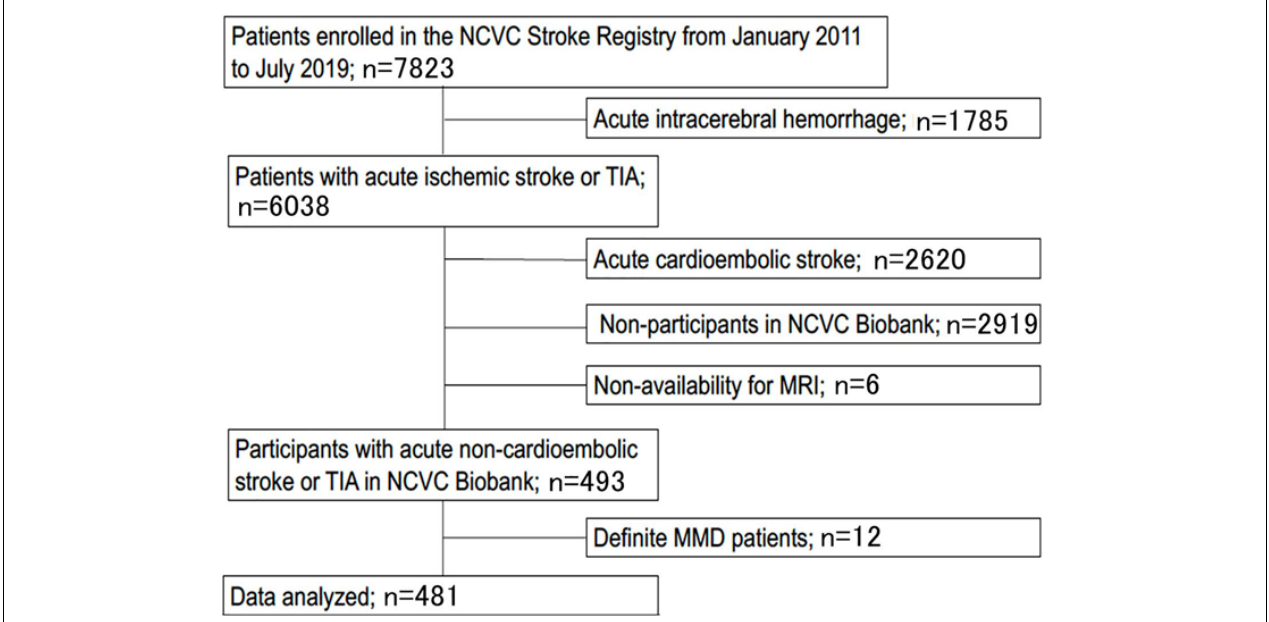
FIGURE 3 | Study flow chart. Patients were excluded based on acute intracerebral hemorrhage ( n = 1,785), acute cardioembolic stroke ( n = 2,620), non-participants at the NCVC Biobank ( n = 2,919), non-availability of MRI ( n = 6), and MMD cases ( n = 12). MMD, moyamoya disease; MRI, magnetic resonance imaging; NCVC, National Cerebral, and Cardiovascular Center; TIA, transient ischemic attack.